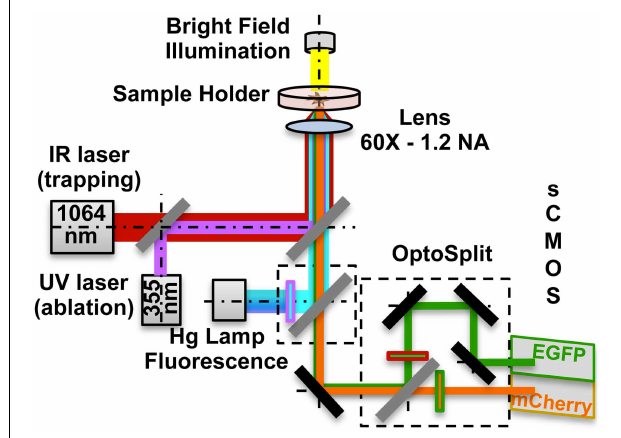
FIGURE 1 | Optical manipulation and FRET imaging setup. The IR laser beam (1064nm) is aligned to the UV laser micro-dissection beam (355nm) and then both are directed into the pupil of the microscope objective (60X - 1.2 NA). The sample is illuminated both by a white light source and a Hg fluorescence lamp. The light coming from the Donor and the Acceptor fluorophores in the sample is separated by a dual emission image splitter and the two images are formed on the two halves of the sCMOS camera